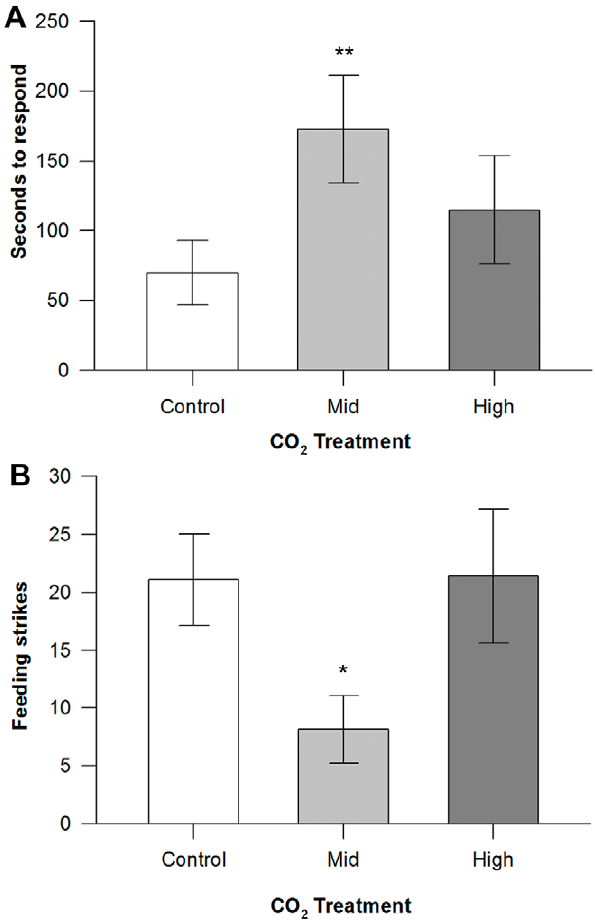
Figure 2. Movement behaviour of Pseudochromisfuscus . A. Mean ( 6 SE) activity levels (denoted by line crosses) and B. mean cumulative distance moved from shelter for P. fuscus following exposure to control (n=10), mid CO 2 (n=8) and high CO 2 (n=7) water treatments. Significance from planned comparisons (control vs. high) at p , 0.05=*.